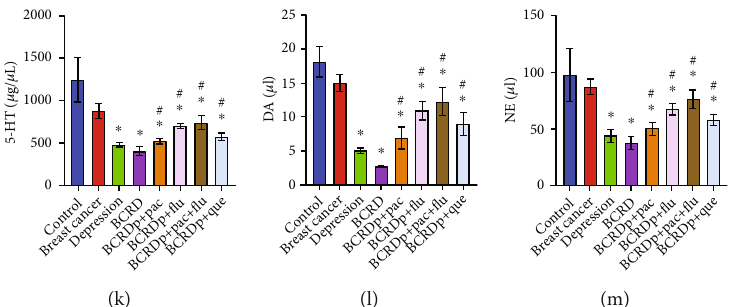
Figure 5: Quercetin alleviated neuron injury and depressive behavior in BCRD mice. (a) The sugar preference rate of mice was detected. (b) The immobility time was recorded after the forced swimming test. (c) The immobility time was recorded after the tail suspension test. (d – f) ASC, NLRP3, and caspase-1 levels in neurons were assessed by RT-qPCR. (g – j) NLRP3, ASC, and caspase-1 levels in neurons were investigated by western blot. β -Actin was applied for quanti fi cation. (k – m) The contents of 5-HT, DA, and NE in mice were detected by ELISA. ∗ p < 0 : 05 compared with control. # p < 0 : 05 compared with BCRD ( n = 6